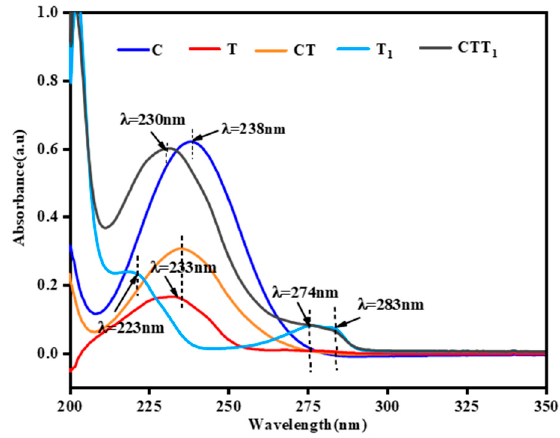
Figure 5. Ultraviolet absorption spectra of the standard solutions (C, citral standard solution; T: Tween 80 standard solution; CT, standard solution mixed of citral and Tween 80; T 1 , thymol standard solution; CTT 1 , standard solution mixed of citral and thymol).